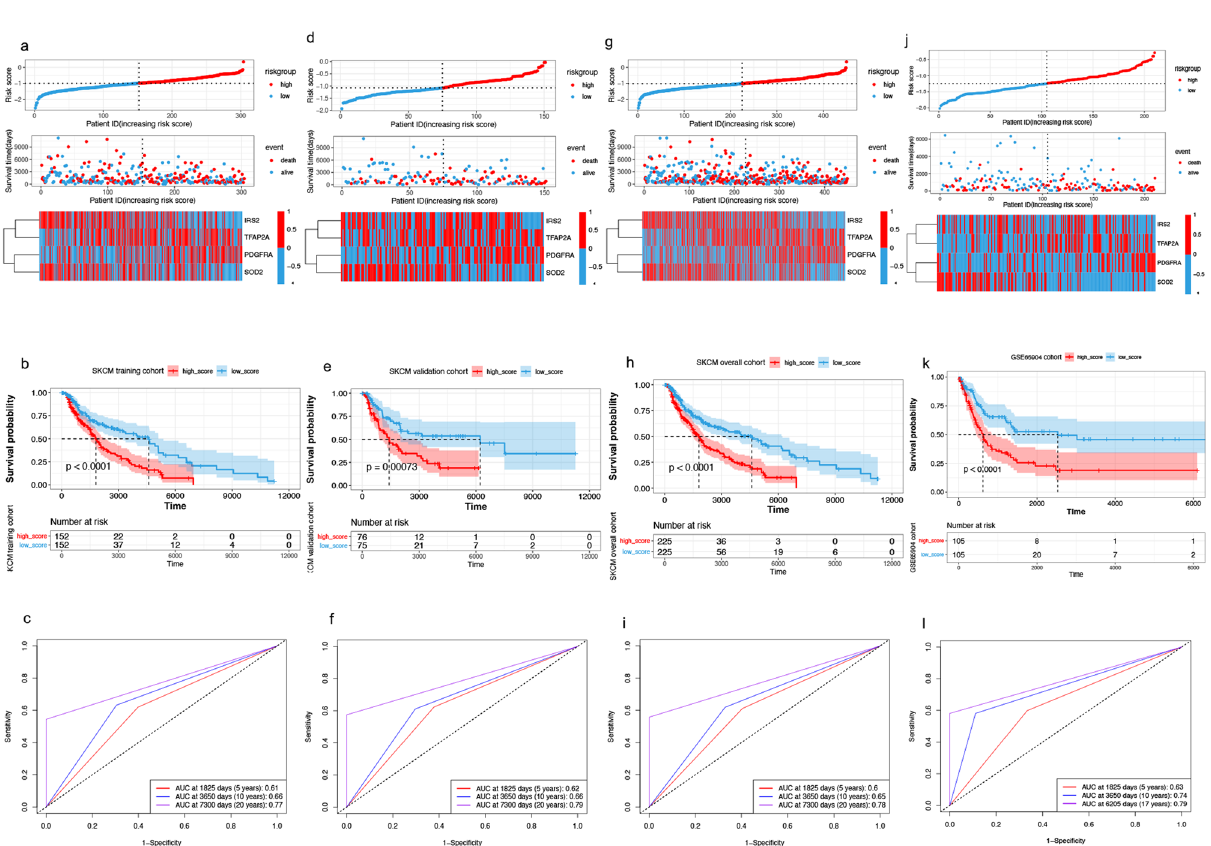
Figure 3. Construction and validation of risk-scoring models. ( a ) Distribution of the risk score, survival status, and expression of four prognostic ARGs in the training queue. ( b , c ) Overall survival curves for patients in the high- and low-risk groups and AUCs in the training queue. ( d–f ) Presentation of the above metrics in the validation queue. ( g–i ) Presentation of the above metrics in the overall queue. ( j – l ) Presentation of the above metrics in the GSE65904. ARG age-related gene, AUC area under the receiver operating characteristic